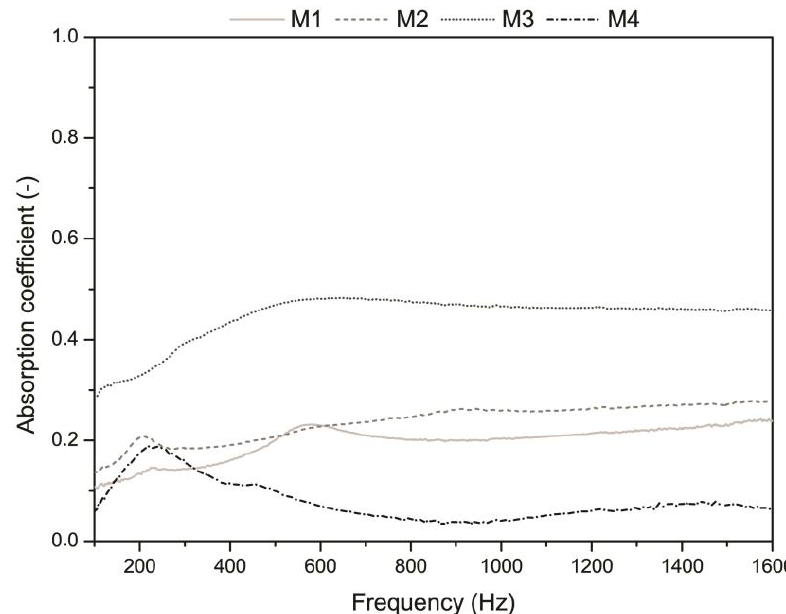
Figure 12. Absorption coefficient of the unbound samples.